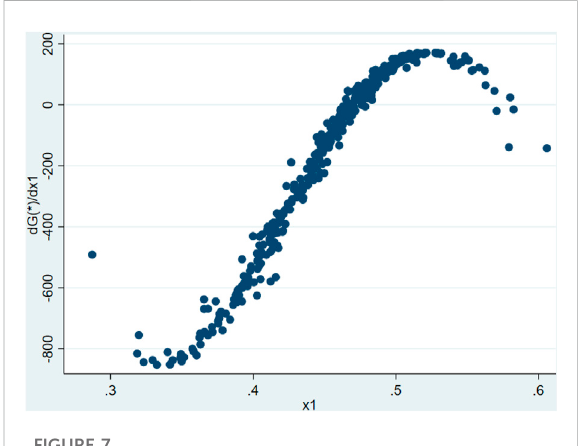
FIGURE 7 Partial derivative of in fl uence of high-quality economic development on carbon emissions.